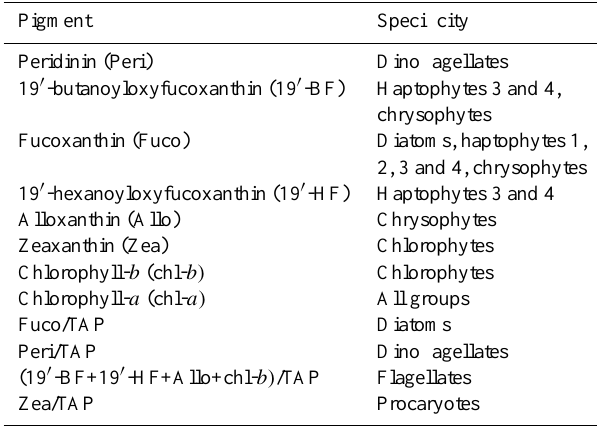
Table 2. Major taxonomically significant pigments in phytoplank- ton groups and their abbreviations (Jeffrey and Vesk, 1997) and definitions of four major algal assemblages determined by pigment composition (Aiken et al.,